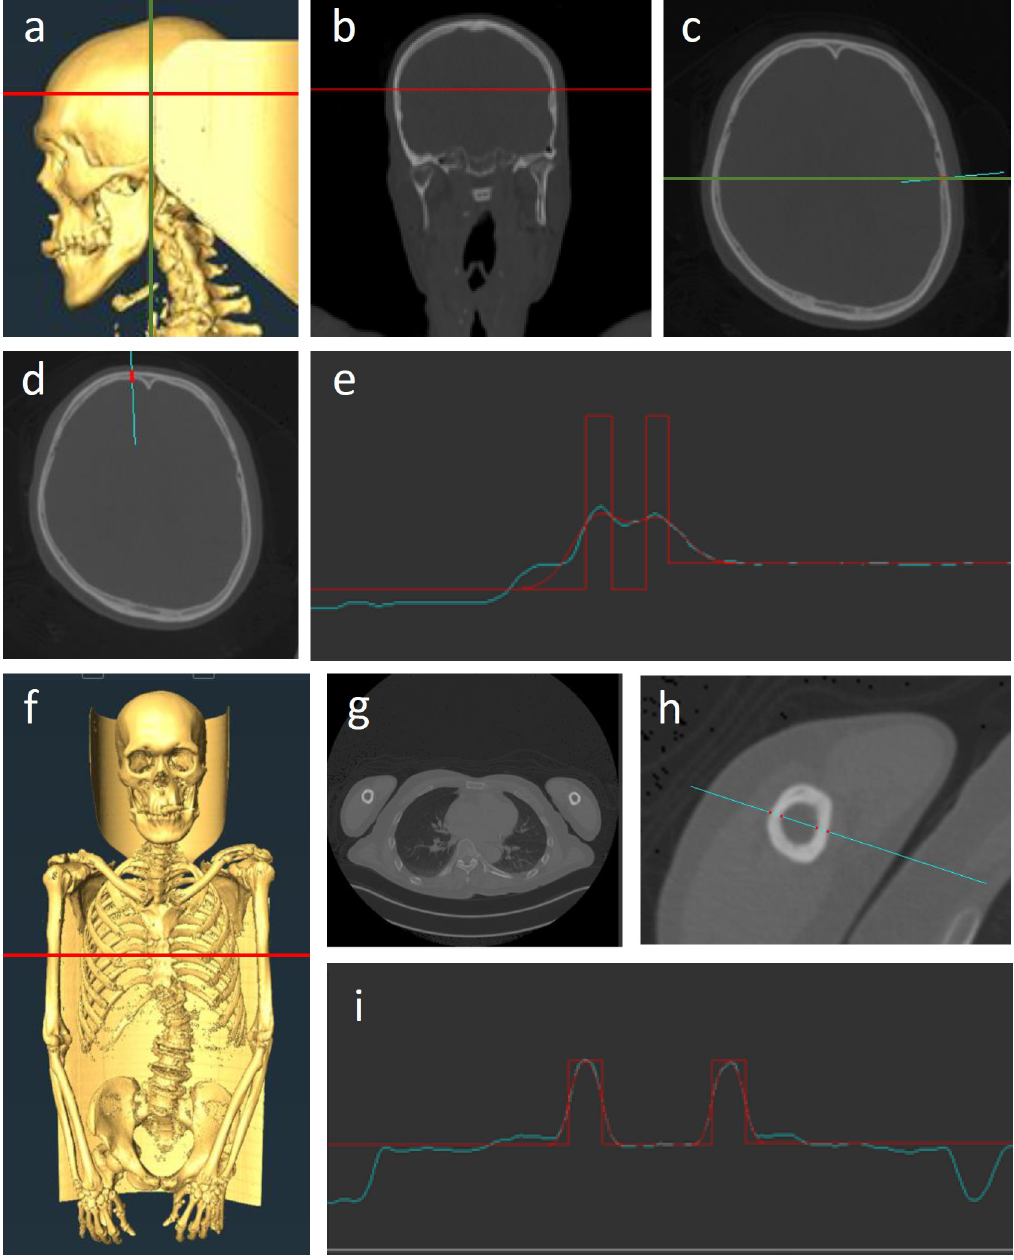
Fig 1. Measurement of bone thickness based on CT images. Measurement of TCVT (a-c), FCVT full , FCVT cortical (d, e), HCT, and HBW (f-i) using Stradwin 5.4. (a-c) The green line denotes the coronal plane passing through the mandibular fossa. The red line denotes the transverse plane passing through the thinnest point of the temporal bone. (c, d, h) Measurement of cortical bone thickness along a line running through the cortex (the blue line). (e, i) Measurement is based on the intensity. (CCI), defined as FCVT /FCVT , and humeral cortical index (HCI), defined as HCT/ cortical full HBW, were used as variables. Averages between two groups were compared using a t -test. Multiple regression analysis was performed to identify factors associated with the measure- ments or indices, including sex, age, height, weight, ancestry, and interaction between sex and